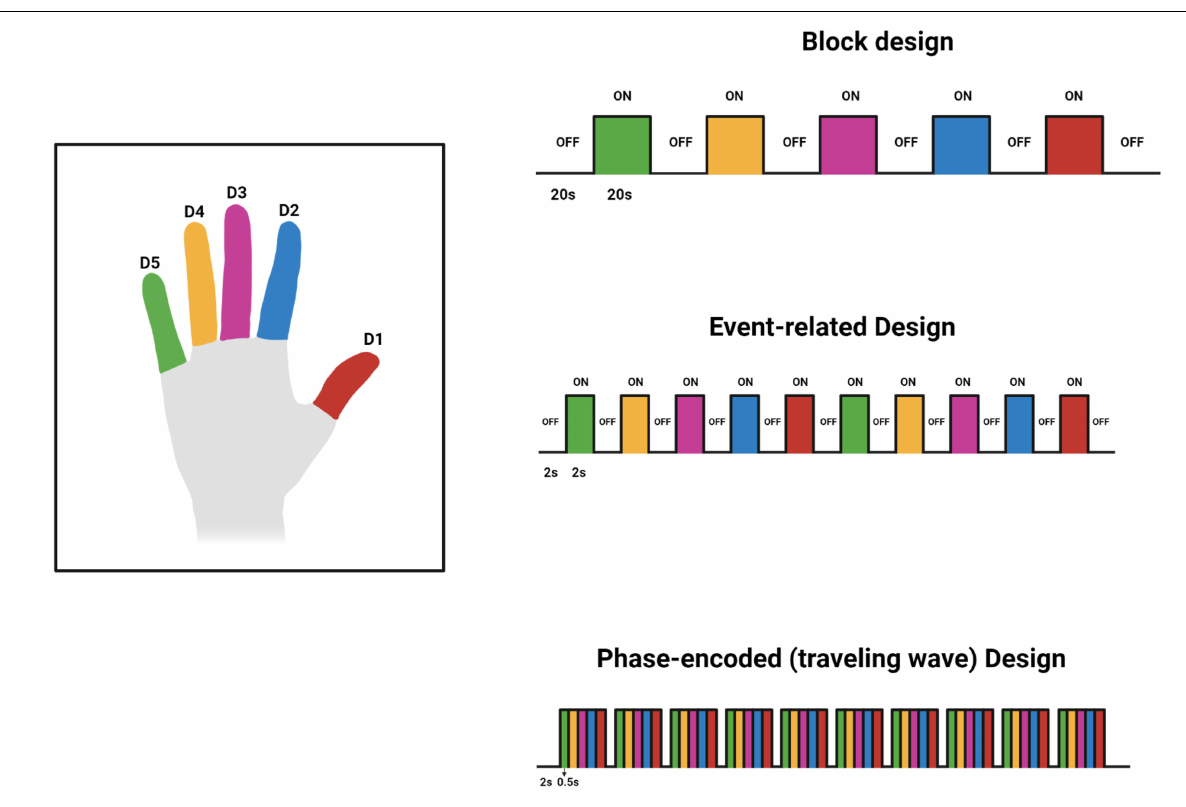
Frontiers in Neuroanatomy |